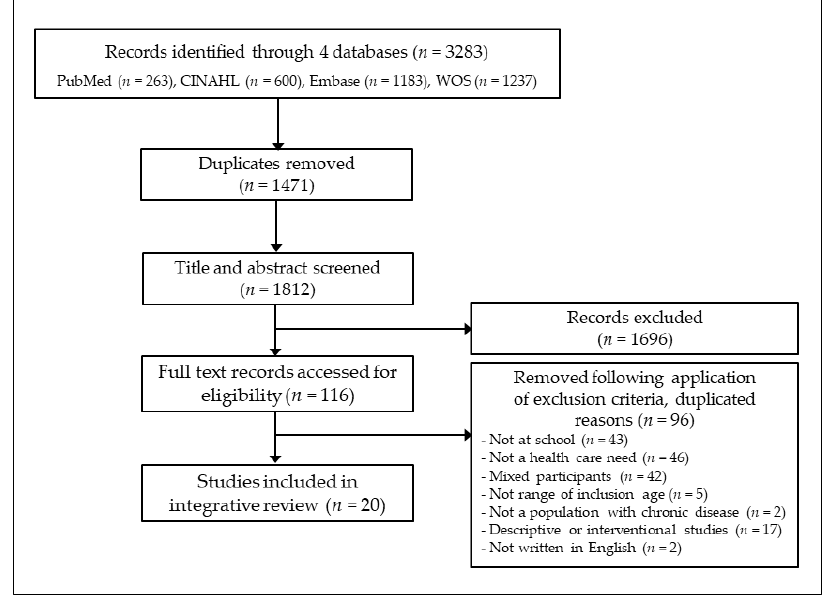
Figure 1. Preferred Reporting Items for Systematic Reviews and Meta-analyses (PRISMA) flow diagram was applied [21], with the flow diagram showing the search process. CINAHL, Cumulative Index to Nursing and Allied Health Literature; WOS, Web of